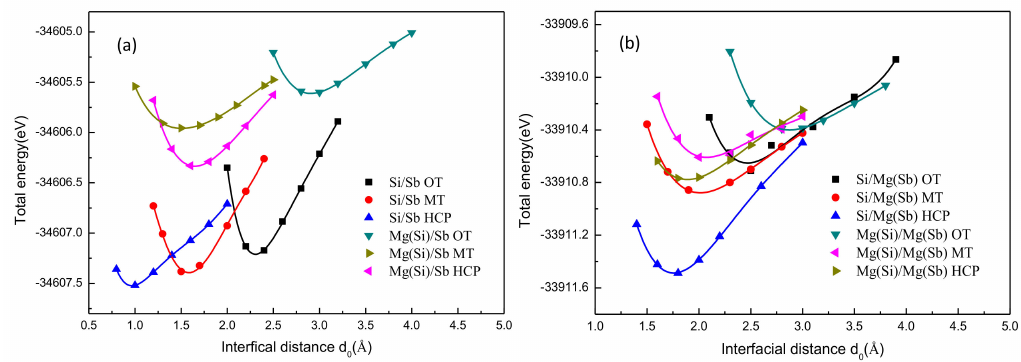
Figure 6. Total energy of the interfacial supercell as a function of the interface distance for 12 di ff erent models: ( a ) Sb-terminated Mg 3 Sb 2 (0001) models and ( b ) Mg-terminated Mg 3 Sb 2 (0001)